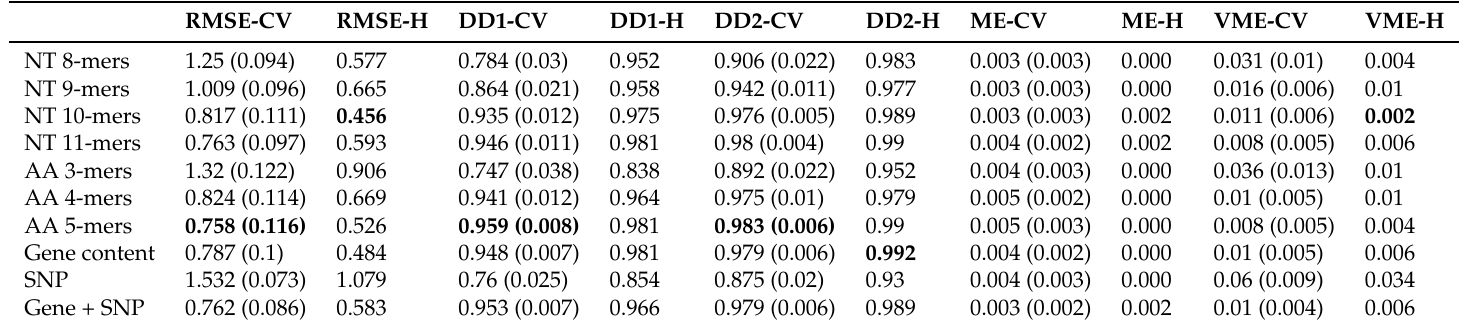
Table A51. S. enterica –ampicillin.